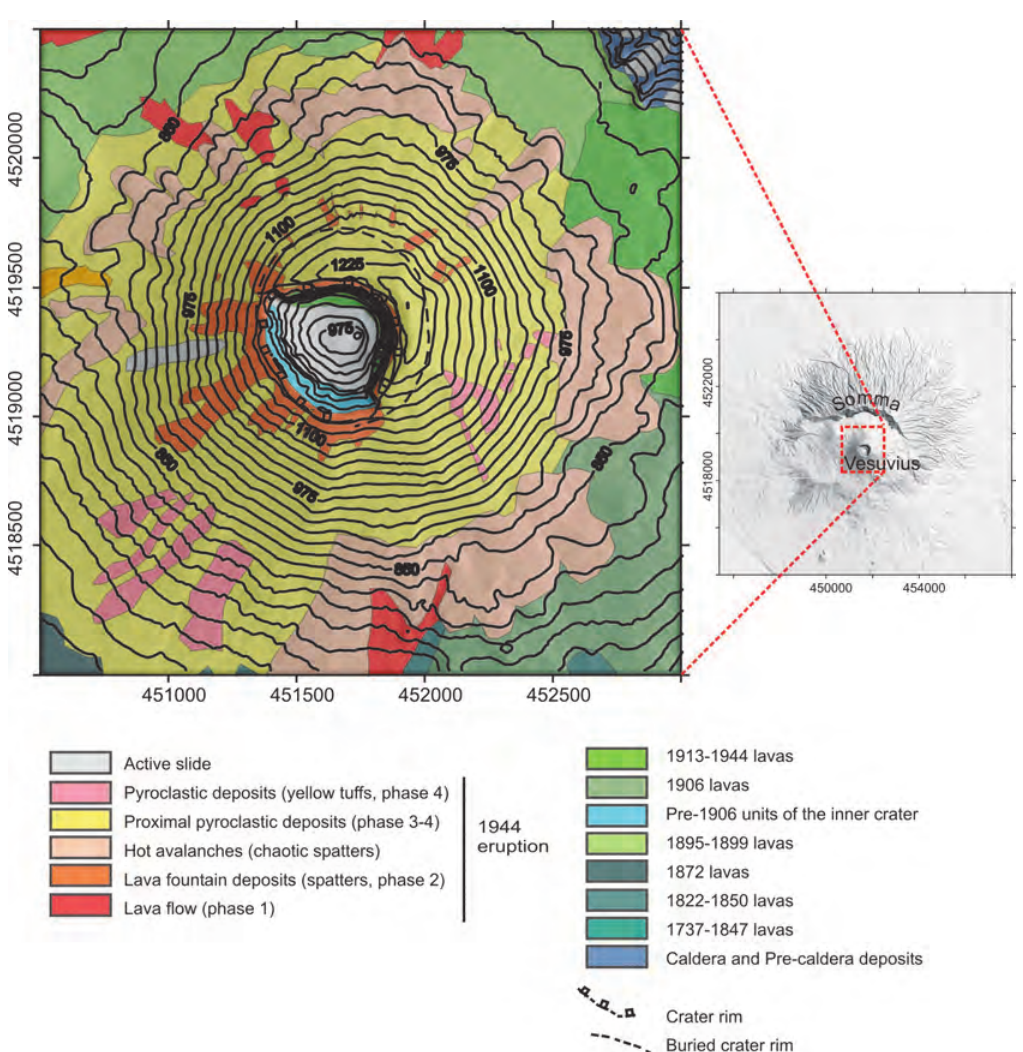
Fig. 1. Digital terrain model of the Somma-Vesuvius volcano and simplified geological sketch map of the Vesuvius crater (modified from Santacroce, 1987). The reference frame is the WGS84 (UTM